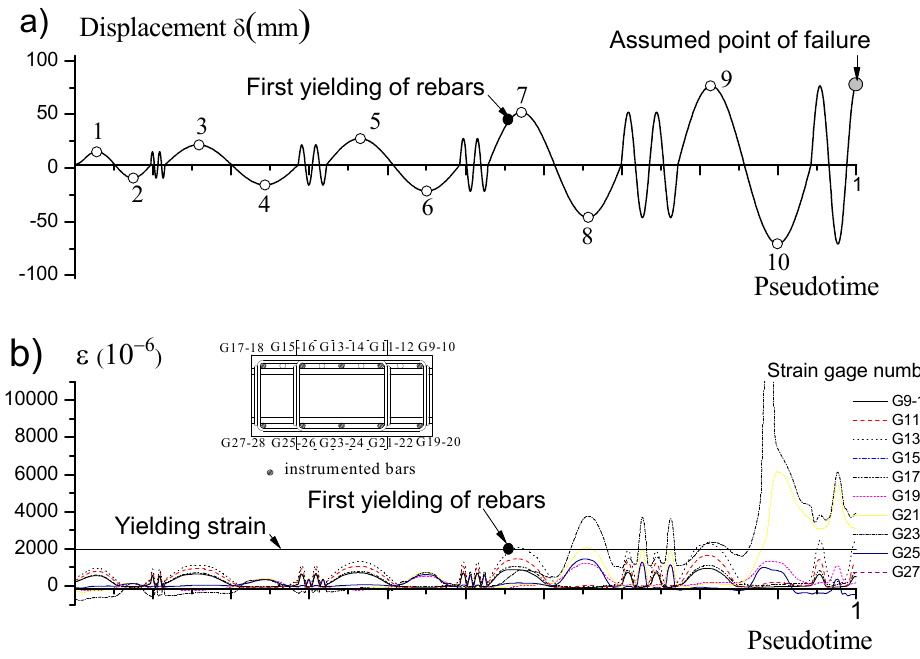
Figure 12. Displacement history applied to beam-column connection ( a ) and corresponding strains in gauges ( b ).